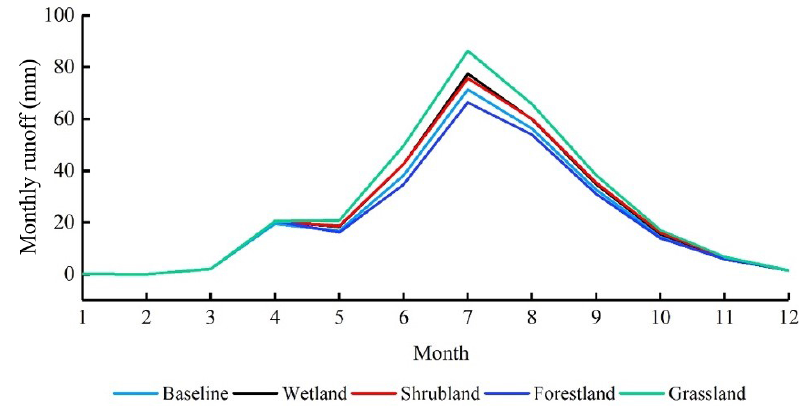
Figure 6. Simulation of monthly runoff under extreme land-use scenarios.